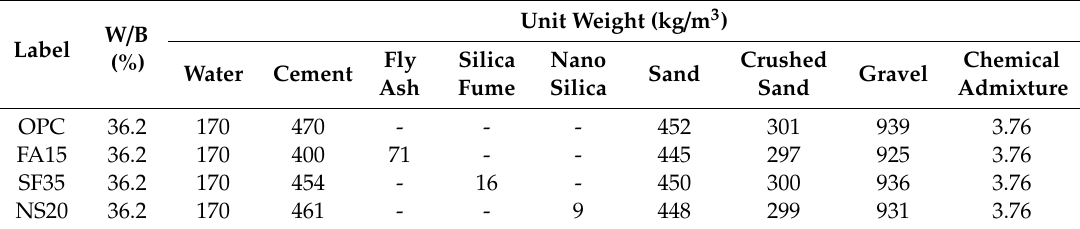
Table 3. Mixture